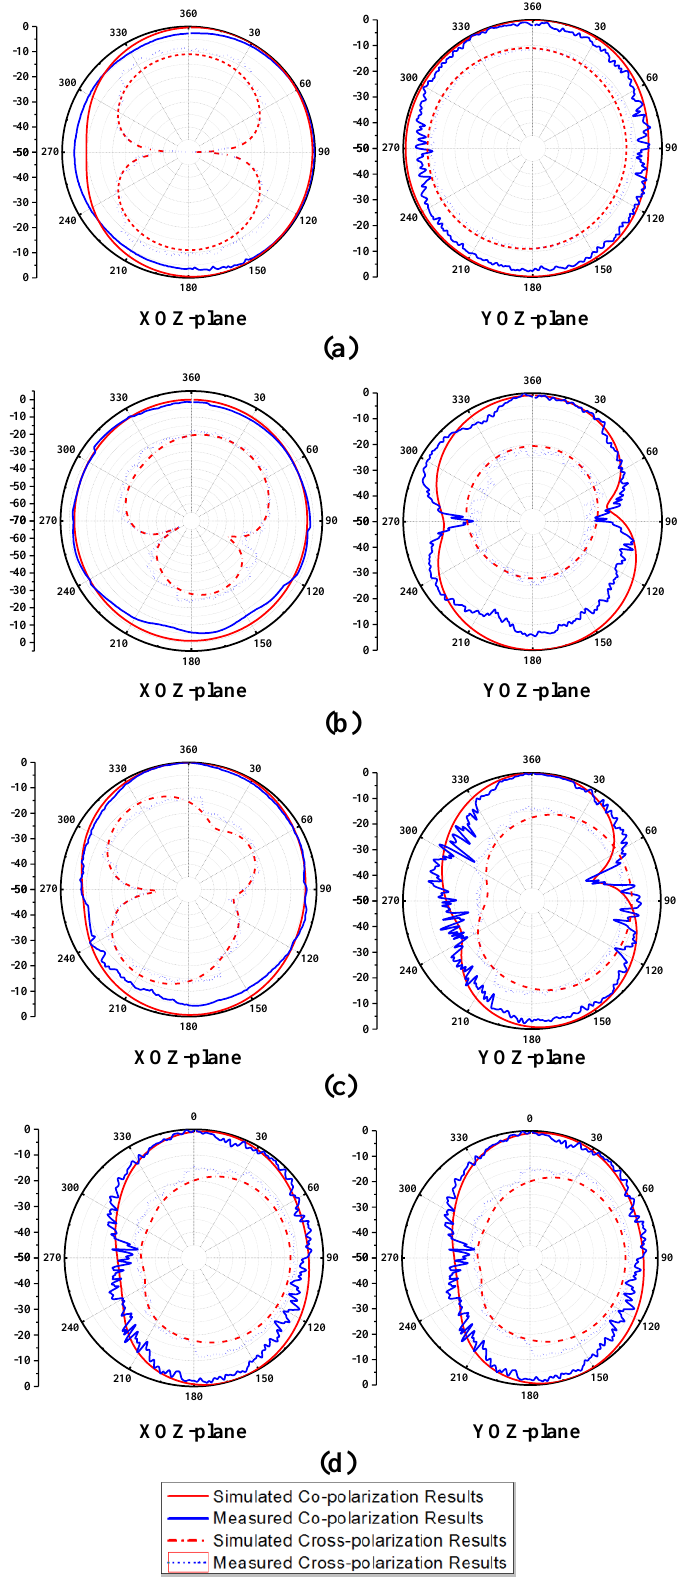
Figure 15. Simulated and measured radiation patterns in x-o-z-plane and y-o-z-plane at: ( a ) 2.4 GHz, ( b ) 3.5 GHz, ( c ) 5.2 GHz, ( d ) 5.8 GHz.